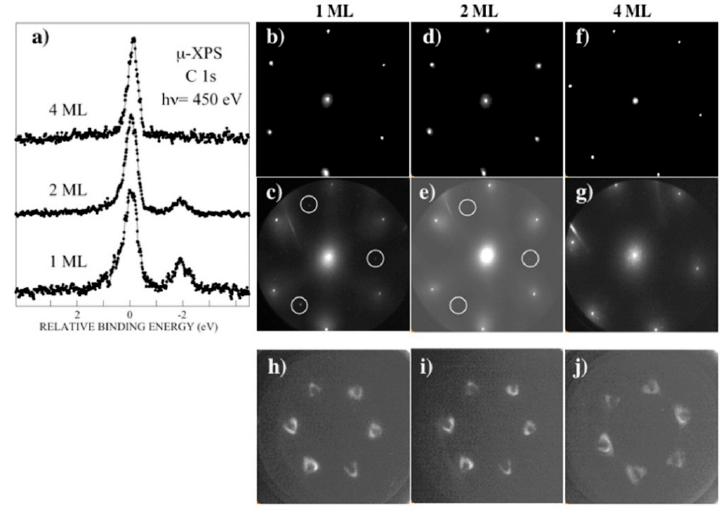
Figure 28. ( a ) C 1s spectra collected, using a probing area of 4 µm, from domains with different graphene thickness; ( b – g ) show 1.5 µm selected area LEED patterns; ( b , c ) the one ML domain at 45 and 145 eV; ( d , e ) the two ML domain at 45 and 145 eV; and ( f , g ) the four ML domain at 45 and 130 eV, respectively. In ( h – j ) the photoelectron angular distribution pattern (PAD) collected from, respectively, the one ML, two ML and four ML domains are shown. The PADs were collected at an energy of 1.5 eV below the Fermi level, using a probing area of 800 nm